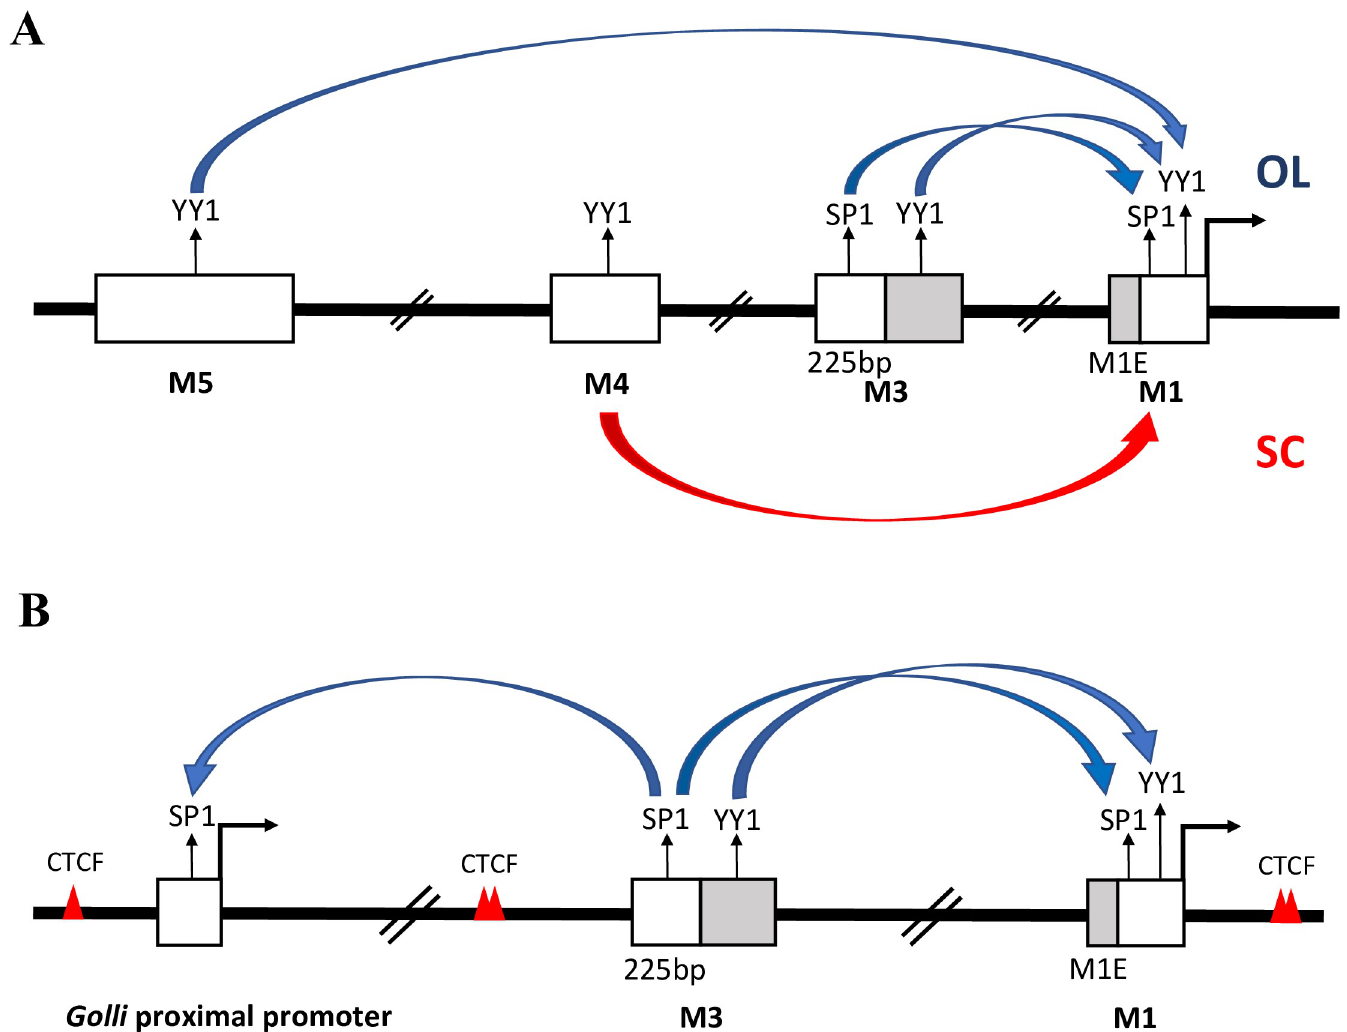
Fig 6. A tentative DNA-looping model for enhancer engagement. (A) The predicted direct enhancer-promoter interaction for Mbp expression in oligodendrocytes (top with blue arrows) and Schwann cells (bellow with the red arrow). (B) The predicted relationship between M3 and the Mbp and Golli promoters. White boxes = enhancers and proximal promoters. Deleted sequences are highlighted in grey. Arrows = potential interactions. Red triangles = CTCF binding